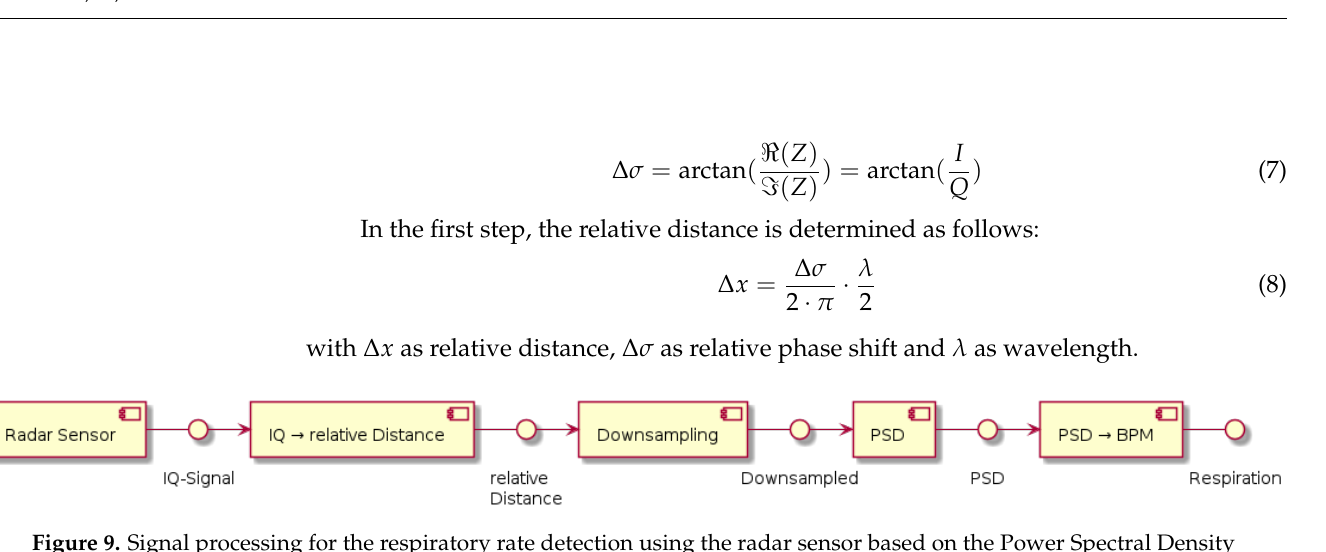
Figure 9. Signal processing for the respiratory rate detection using the radar sensor based on the Power Spectral Density (PSD) calculated from